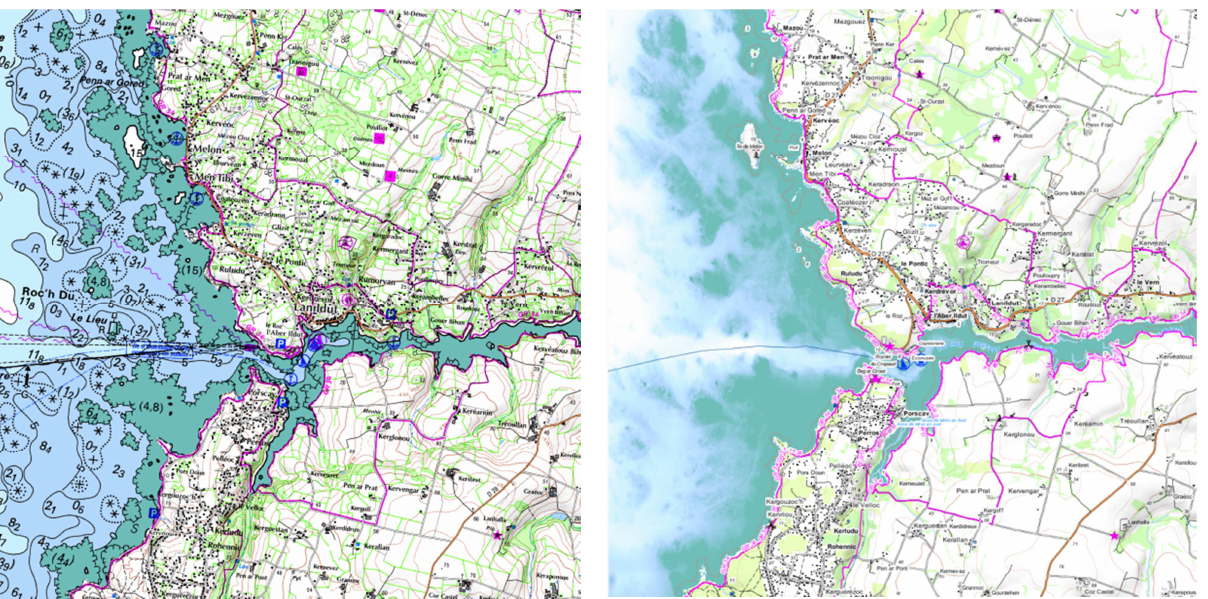
Figure 4. ScanLittoral® map, scale 1:25,000 Figure 5. Resulting geovisualization of application 1, scale